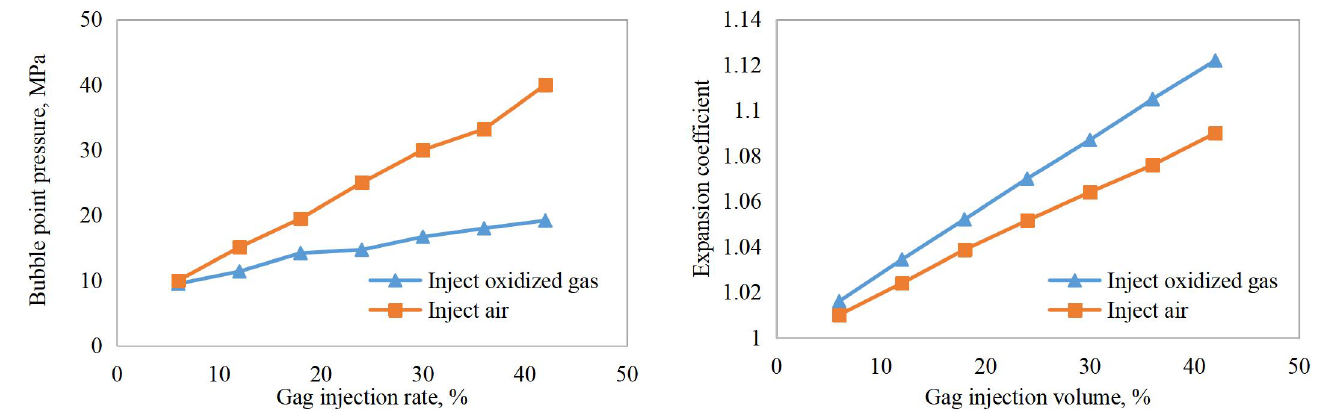
Figure 4—P-X phase diagram of air and oxidized gas with crude oil.